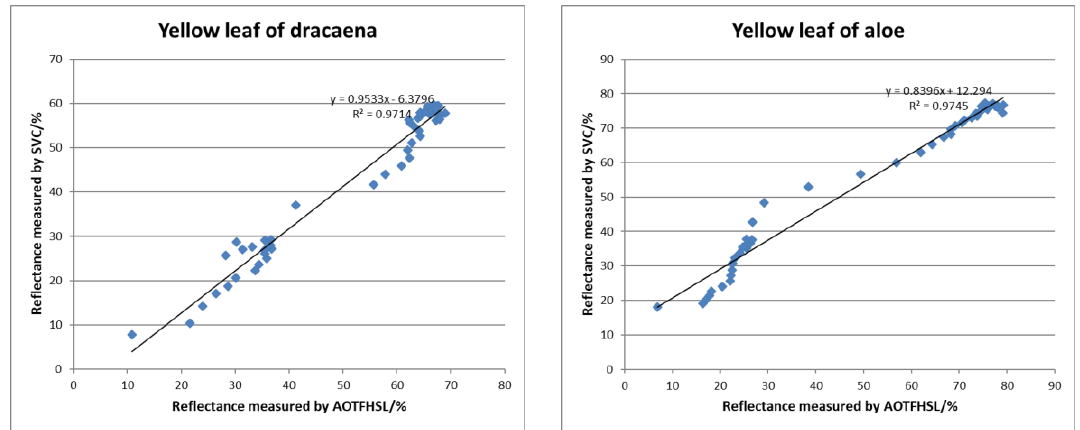
Figure 11. Scatter diagrams of the reflectance of yellow leaf cases measured by AOTF-HSL and SVC spectrometer.